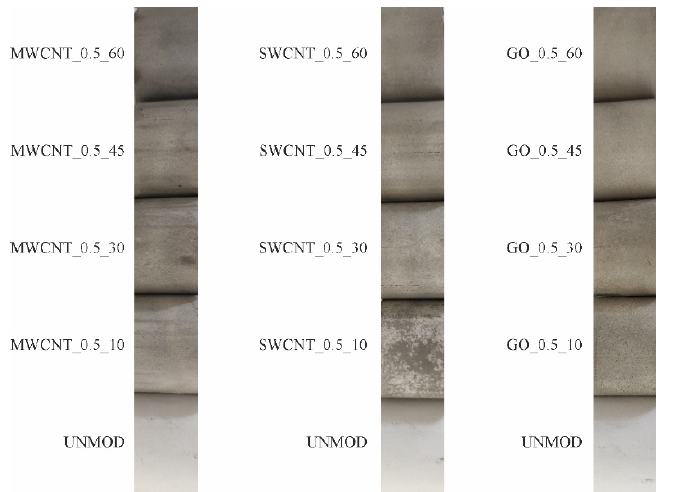
Figure 4. Images of the test membrane samples. Photo taken by 12MPx camera without magnifica- tion.